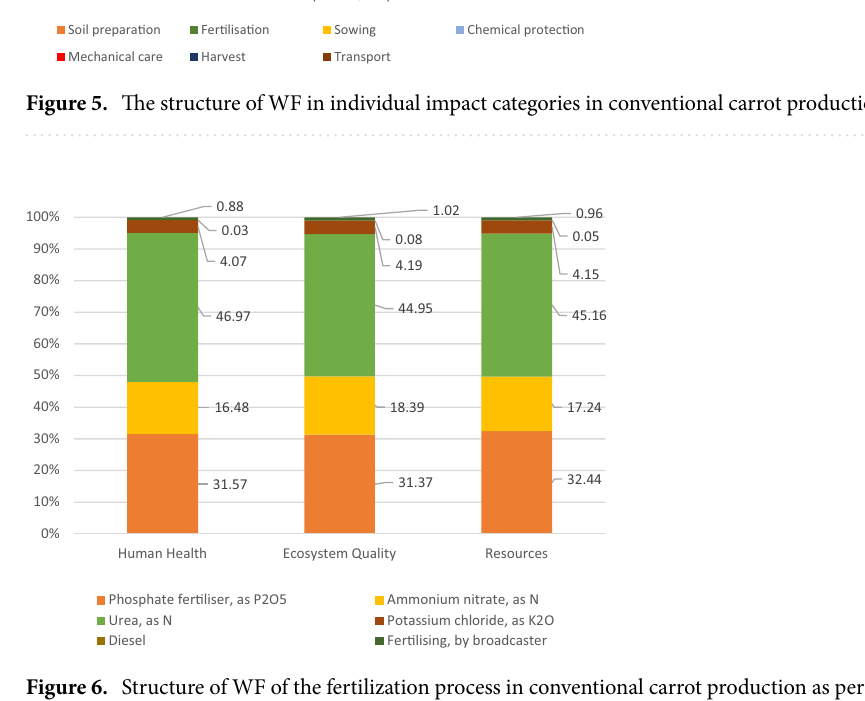
Figure 6. Structure of WF of the fertilization process in conventional carrot production as per individual impact